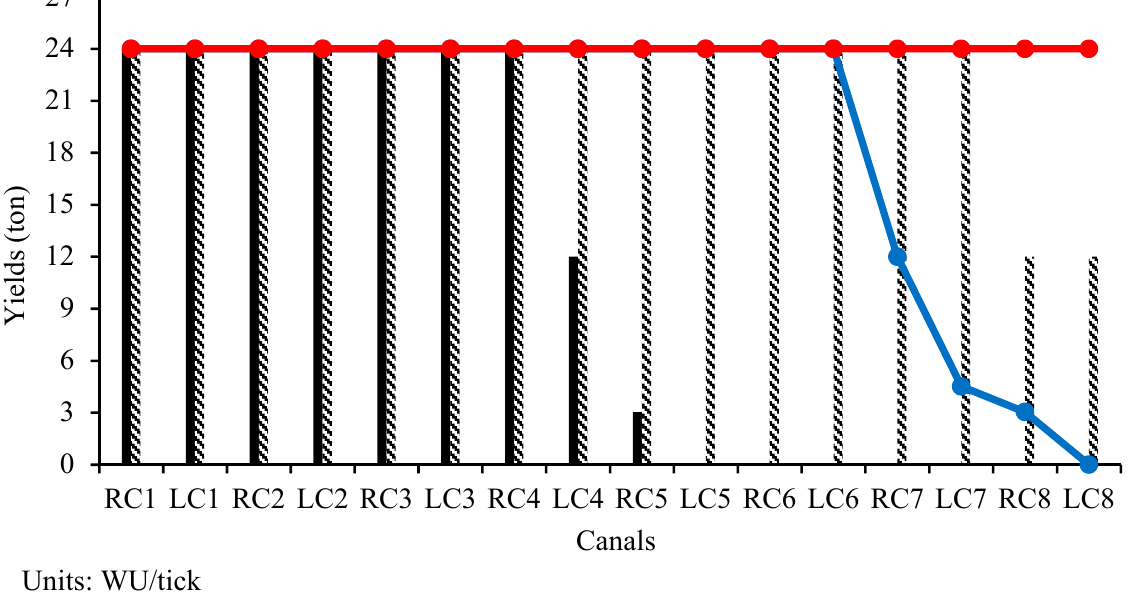
Figure 4. Yields per canal with sufficient water under Demand Control and low Gate Capacity (RC = Right Canals; LC = Left Canals; Number indicates position along the canal—see Figure 2).